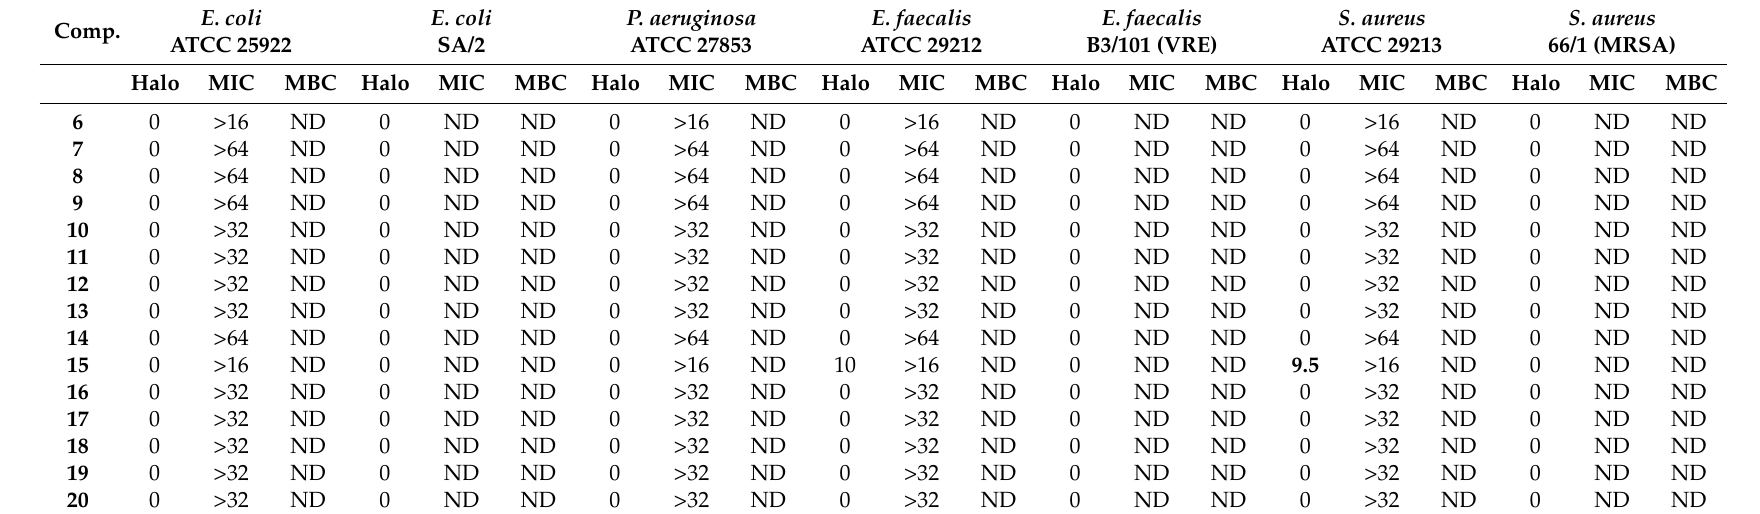
Table 3. Antibacterial activity of the compounds 6 – 20 . MIC and MBC 1 are expressed in µ g/mL. Inhibition halos 2 are expressed in mm.